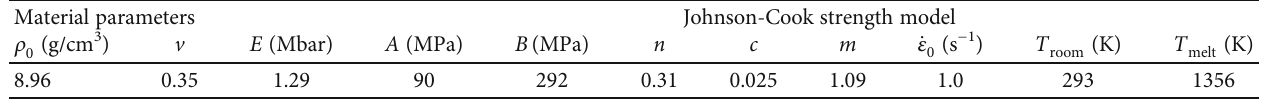
Table 2: The material constants for